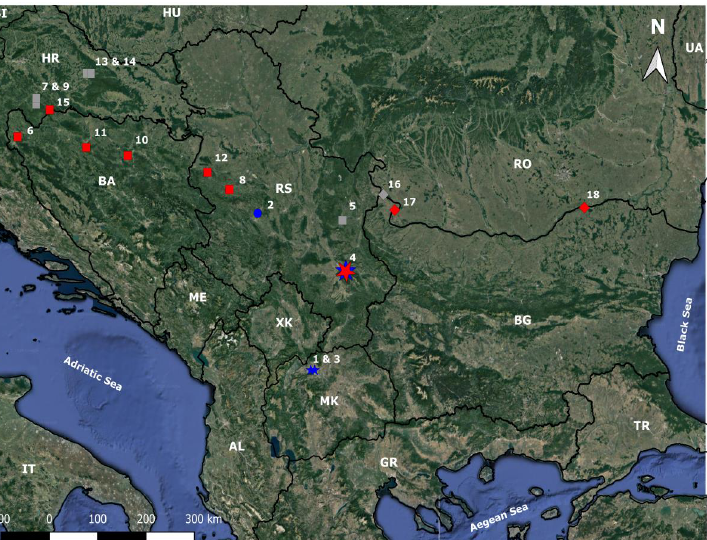
Figure 1. Map showing sampling localities; the numbers (1–18) correspond to the numbers of the localities in Table S1. Colours depict haplotype groups: red— S. bulgarica , blue— S. balcanica , grey— localities are not included in cyt b analysis. Shapes: red square— S. bulgarica in Danube River basin; blue circle— S. balcanica in Danube River basin; blue/red star—co-occurrence of S. balcanica and S. bulgarica in Danube River basin (Black Sea drainage); blue stars —S. balcanica in Vardar River catchment (Aegean Sea